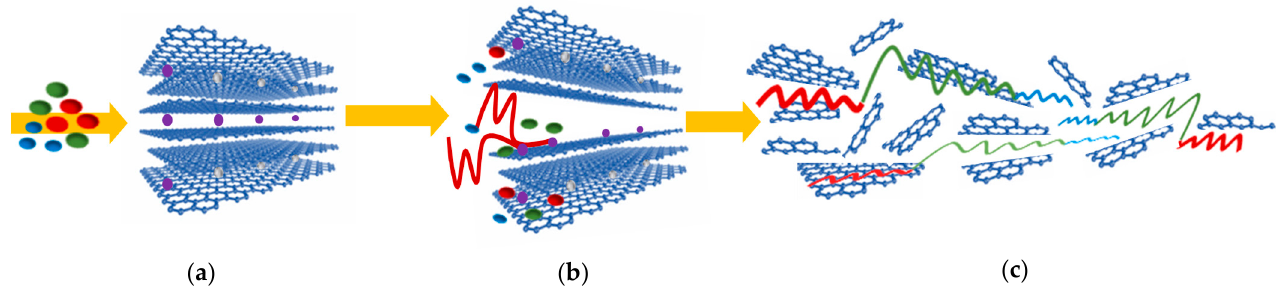
Figure 1. Tentative mechanism of the copolymerization process initiated by KC 24 . ( a ) Monomer diffusion/absorption; ( b ) initiation/copolymerization; and ( c ) chain growth/GIC delamination. Red: styrene monomer/block; green: methyl methacrylate monomer/block; blue: ethylene oxide monomer/block; and purple: K-cation.